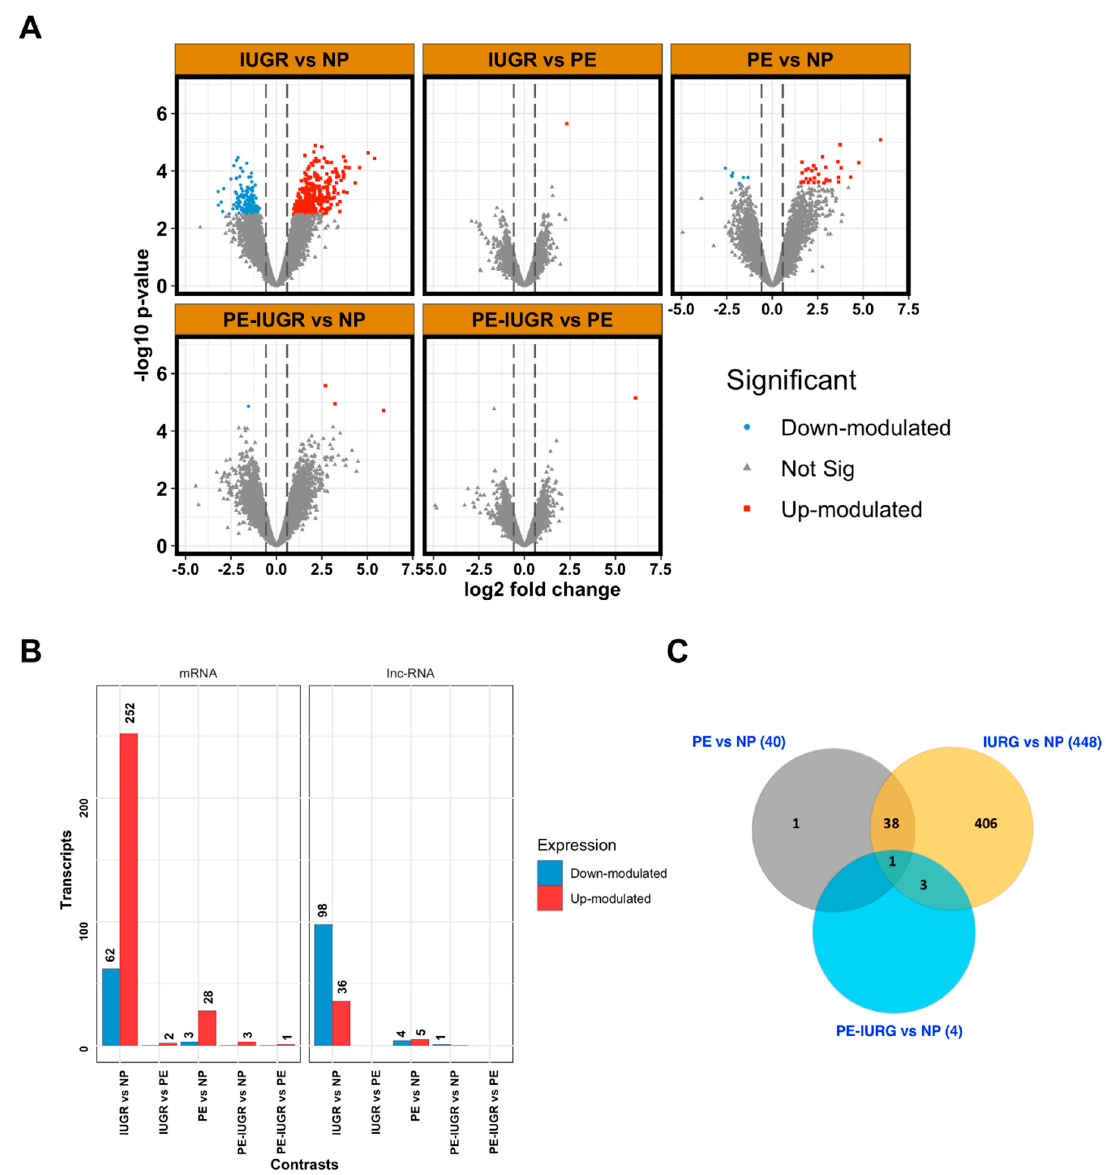
Figure 1. Distribution of di ff erentially expressed genes in di ff erent comparisons between clinical groups. ( A ) Volcano plots show the di ff erentially expressed genes for any of the comparisons made between di ff erent clinical groups. The y -axis indicates the statistical significance expressed as the-log10 of the p -values and the x -axis shows the rate of expression change between experimental groups in log2 base (log2 Fold change). Red dots indicate significantly over-expressed genes (with a log2 Fold change > 1.5 and adjusted p value < 0.1) and blue dots indicate significantly under-expressed genes (with a log2 Fold change < − 1.5 and adjusted p value < 0.1). ( B ) The number of over- and under-expressed genes divided by transcript type are represented vertically in each comparison between groups representing di ff erent clinical conditions as indicated. ( C ) Venn diagram displaying the number of transcripts that show similar significant di ff erential expression in di ff erent comparisons between groups. PE, preeclampsia; IUGR, Intrauterine Growth Restriction; PE-IUGR, Preeclampsia with Intrauterine Growth Restriction; NP, Normal